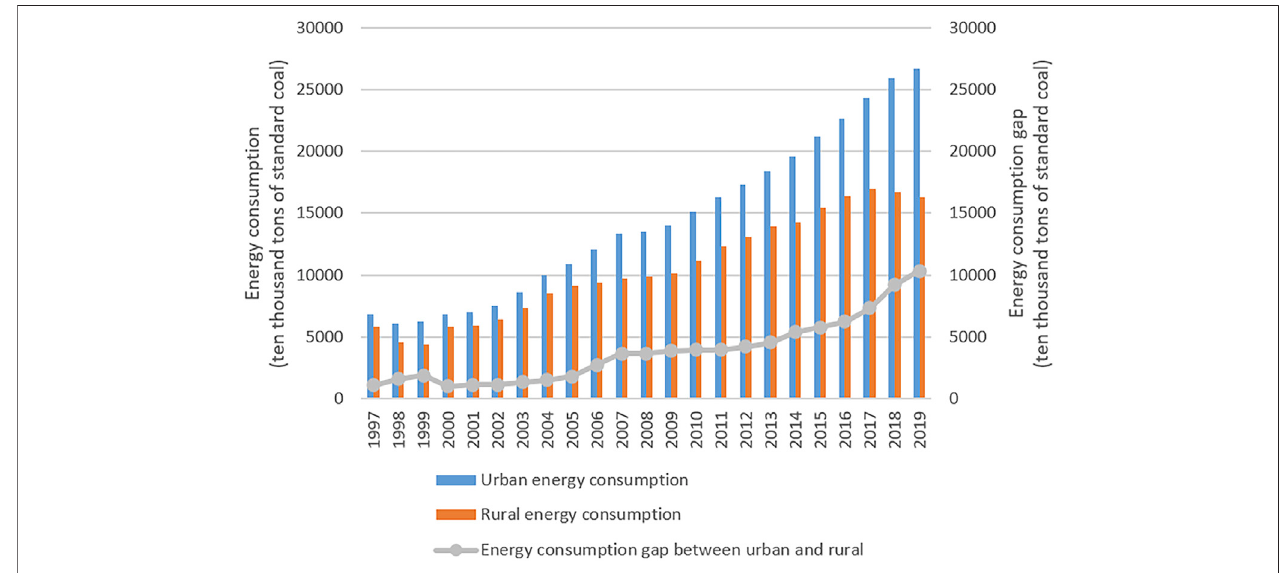
FIGURE 3 | Changes in household energy consumption from 1997 to 2019. Data source: China Energy Statistical